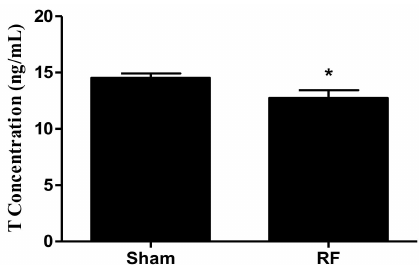
Figure 6. The effect of one-month 220 MHz pulsed modulated RF exposure on the secreting function of testicular Leydig cells (LCs) in SD rats. N = 12 for each group. The values were expressed as means ± SEM and were analyzed by student t -test. * p < 0.05 compared to the sham group.